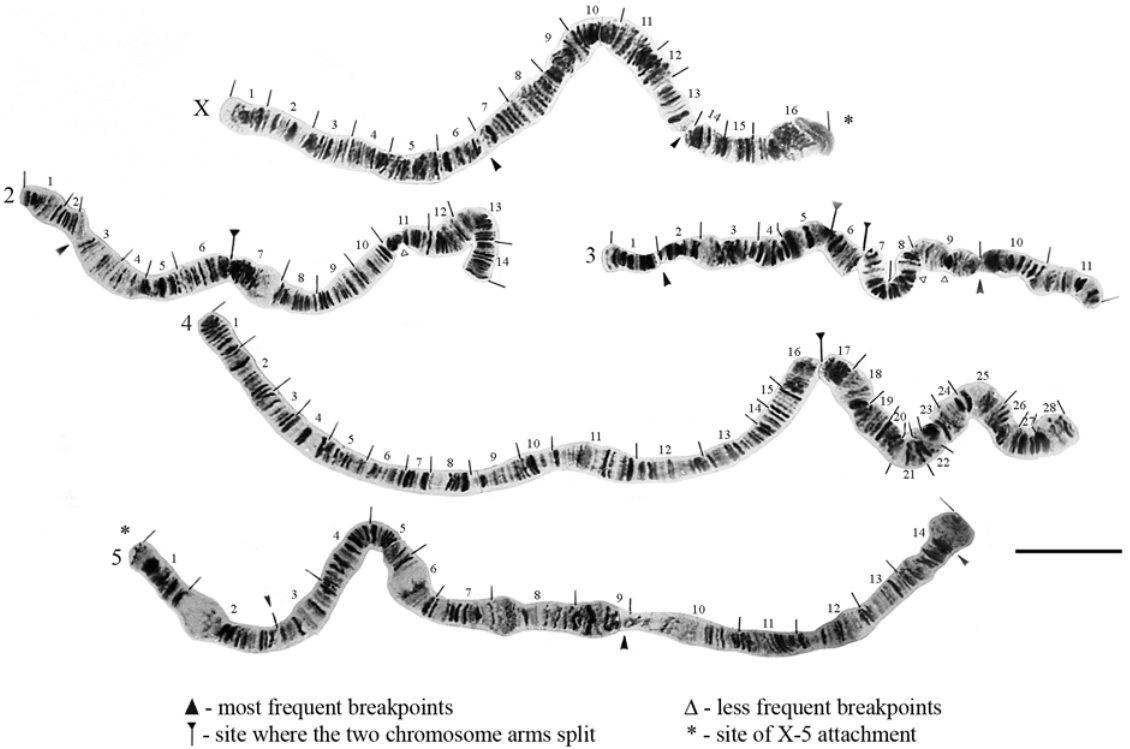
Figure2 -Photomicrographicmapof Drosophilaannulimana polytenechromosomes.InthisspeciestheXchromosomeisverylarge,formedbytheX-5 fusion, and it has been separately mapped to facilitate the comparisons with the species without the fusion. Scale bar = 30 μ